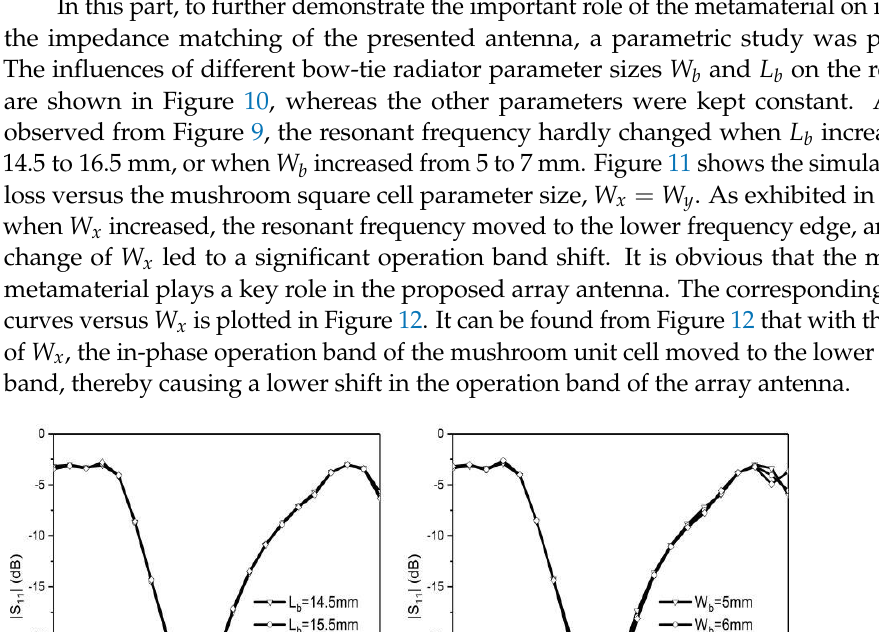
Figure 11. Simulated |S 11 | of the proposed array antenna with different mushroom cell sizes 𝑊 𝑥 . Figure 12. In-phase diagram of mushroom unit cell with different top metal patch sizes 𝑊 𝑥 .